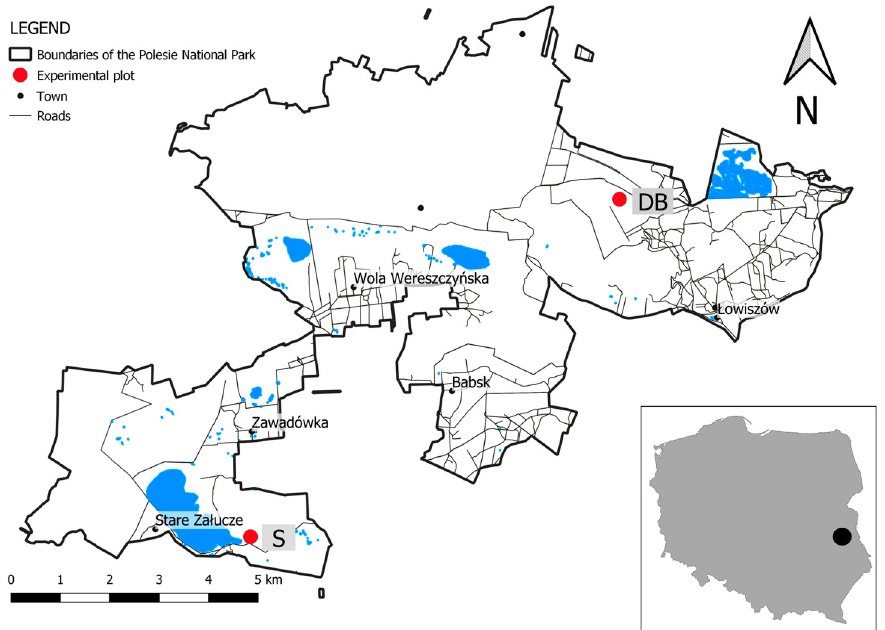
Figure 1. Location of experimental plots: DB—Durne Bagno (51°27’05.83” N/23°13’33.29” E), S—Spławy (51°24’19.96” N/23°06’16.99” E).